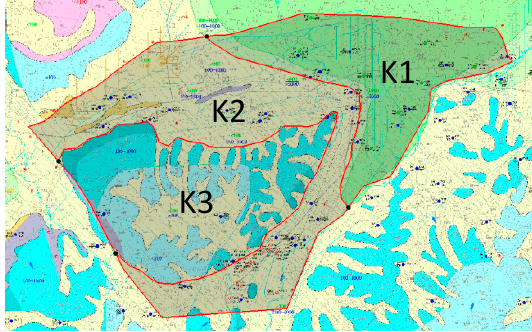
Figure 3. Parameter zoning map of the phreatic aquifer.